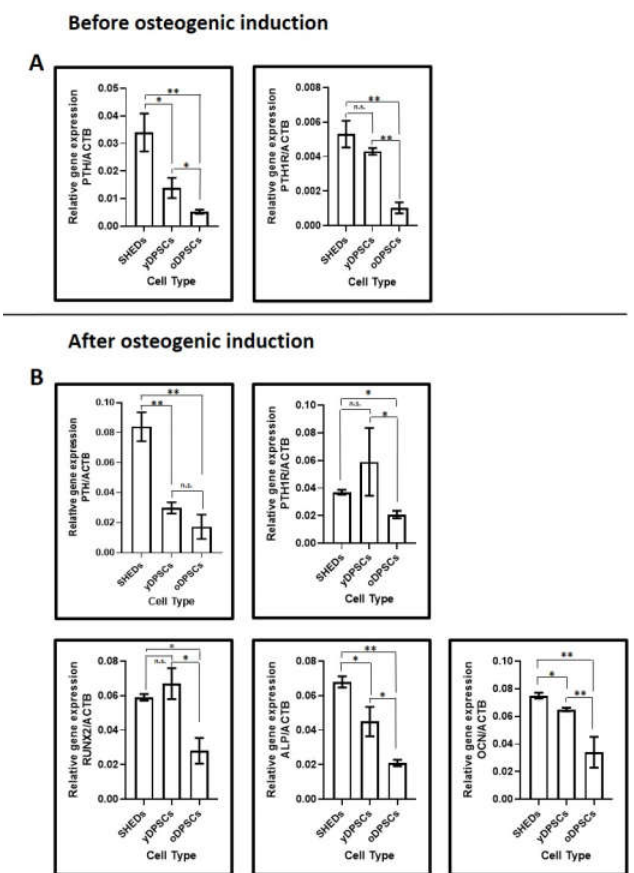
Figure 3. RT-qPCR analysis for estimation of gene expression. ( A ) Comparative gene expression levels of PTH and PTH1R were assessed in SHEDs, yDPSCs, and oDPSCs. ( B ) On the 14th day of osteogenic induction, comparative gene expression levels of PTH, PTH1R, RUNX2, ALP, and OCN were assessed in SHEDs, yDPSCs, and oDPSCs ( n = 5). n.s.: not significant, * p < 0.05, ** p <